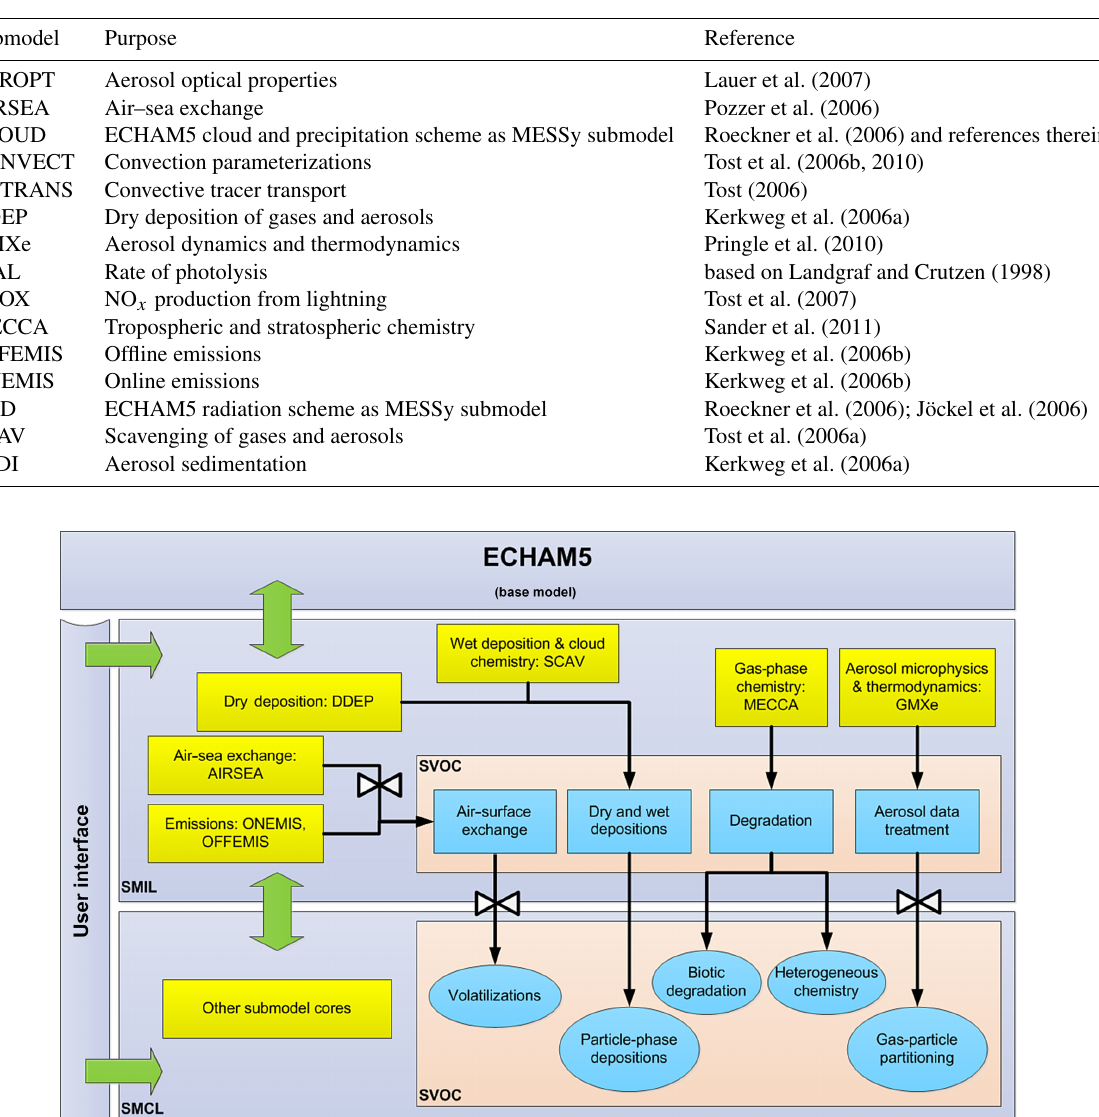
Table 1. Summary of MESSy process submodels used in this study.